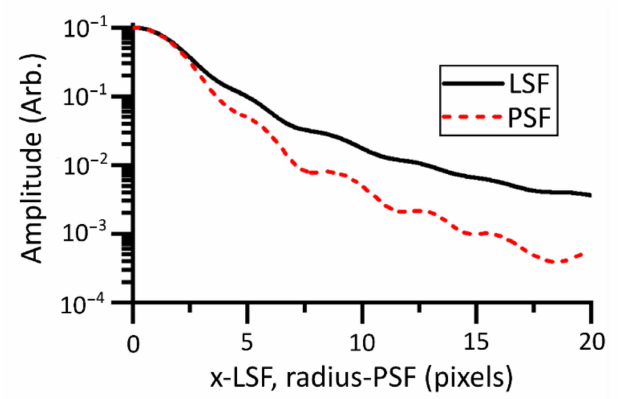
Figure 7. Numeric Abel inversion was used to convert the LSF (one dimensional in x) to the PSF (one dimensional in radius). The PSF has reduced by 3 orders of magnitude within 20